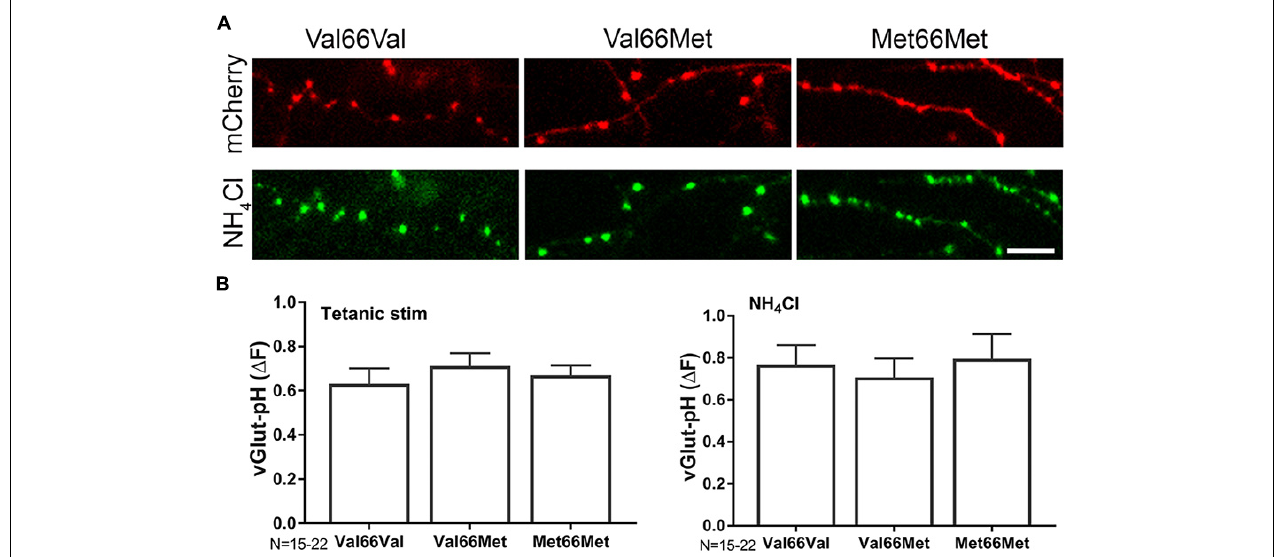
FIGURE 5 | BDNF Val66Met and Met66Met single nucleotide polymorphisms do not affect total synaptic vesicle number or amount of exocytosis. Representative images of 14–16DIV Val66Val (wt), Val66Met, and Met66Met mouse hippocampal neurons transfected with mCherry ( A -top) and vGlut-pH (with NH 4 Cl alkalization, A , bottom). (B) Change in fluorescence of vGlut-pH with tetanic stimulation (left) or NH 4 Cl alkalization (right) reflecting amount of exocytosis or total vesicle number showed no significant differences between the three genotypes. Data are mean ± SD; n = 15–22 neurons per experimental group and 750–1,100 boutons. Scale bar = 5 µ